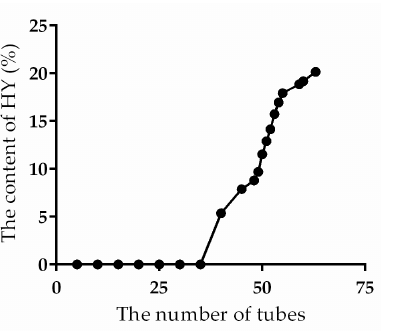
Figure 4. The leakage curve. Note: number of tubes meant the elution solution was collected in a 5 mL tube and the content of HY in each tube was determined. 5 mL tube and the content of HY in each tube was determined.